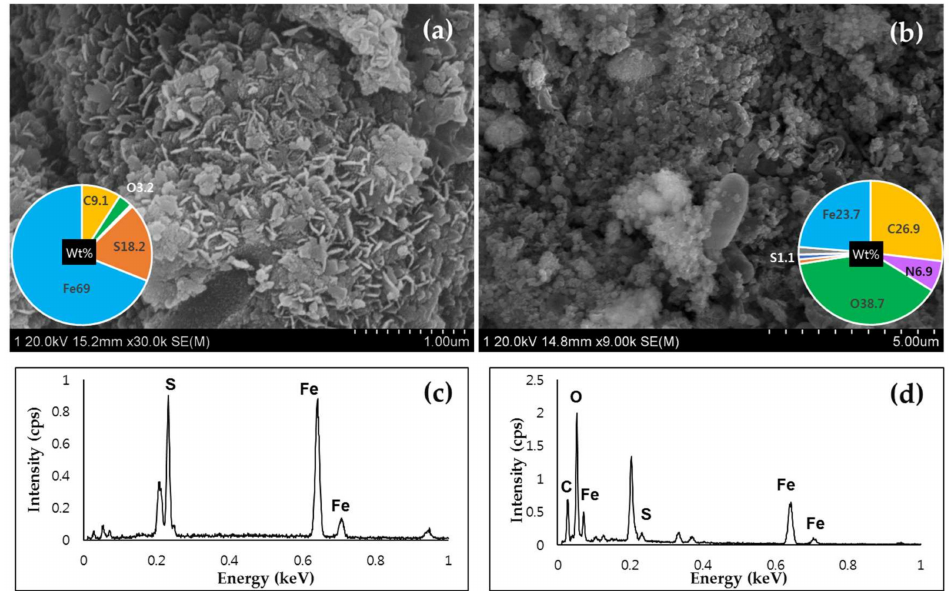
Figure 5. SEM images of ( a ) BF before reaction with a pie graph indicating elemental weight percentage in relation to ( c ) EDS spectra and ( b ) BC + BF after reaction with a pie graphs indicating elemental weight percentage in relation to ( d ) EDS spectra.